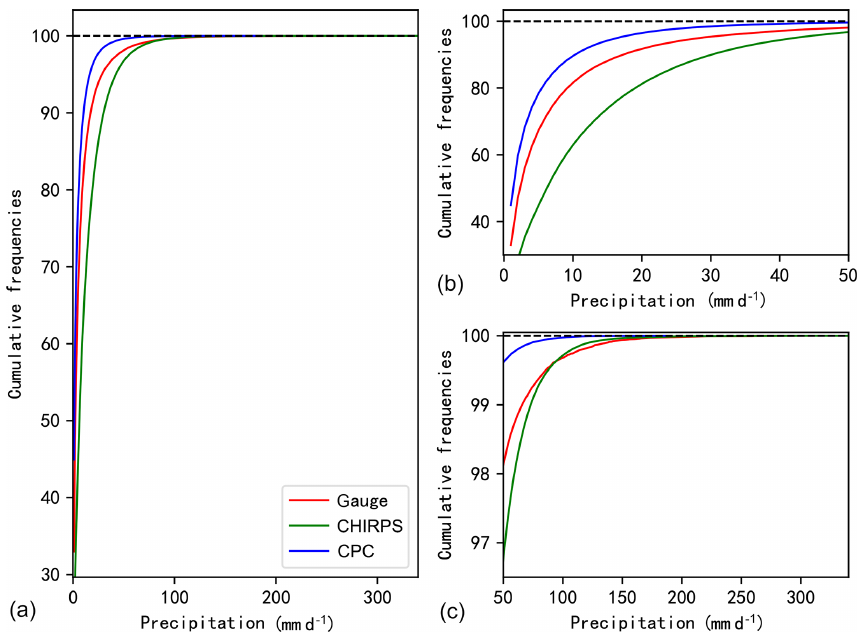
Figure 6. Cumulative frequencies of daily precipitation intensity for the three precipitation products (Gauge, CHIRPS, and CPC) in the JRW: (a) distribution of all precipitation values, (b) distribution of precipitation values that are <100mm, and (c) distribution of precipitation values that are ≥